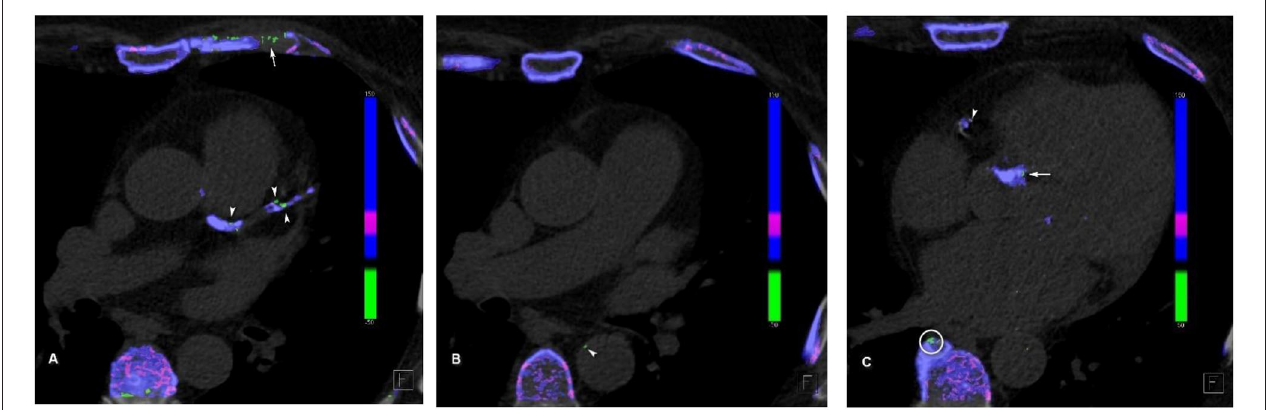
FIGURE 1 | Cardiovascular urate deposits. (A) Urate crystal (green) deposits in the left main coronary artery, left anterior descending artery, and its first diagonal branch (arrowheads). Note the artifactual green deposits in the coastal cartilage (arrow), as it has similar attenuation profile as uric acid. (B) Mural urate deposit in the descending thoracic aorta (arrowhead). (C) Urate deposit in the right coronary artery (arrowhead) and in the aortic valve calcification (arrow). Note the artifactual green deposit at the edge of vertebral osteophyte (circle).